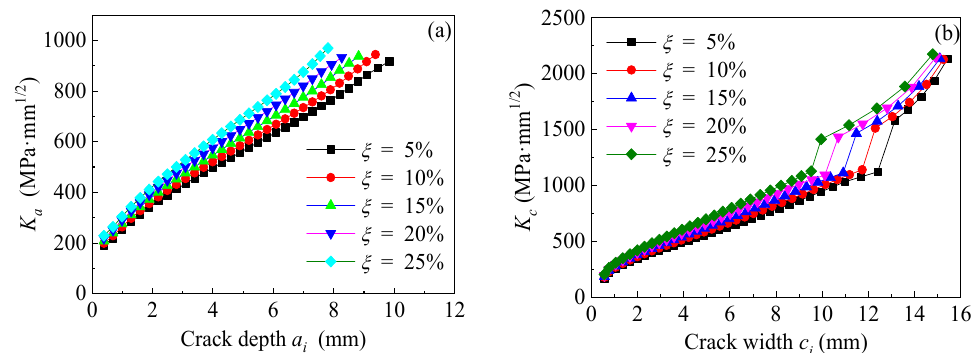
Figure 17. Effect of weight ‐ loss rate of the corroded steel plate on the K ‐ values at crack tip of the corroded steel plate strengthened with CFRP plates: ( a ) K a vs. crack depth a i and ( b ) K c vs. crack width c i .